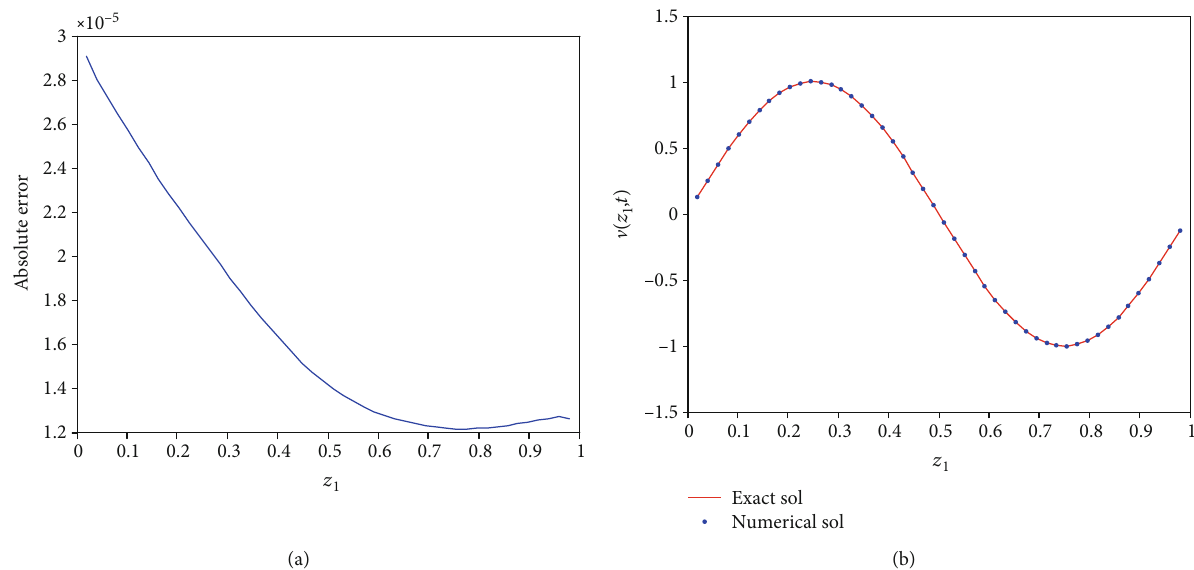
Figure 2: (a) E and (b) exact and approximate solution at α = 0 : 2 for the Problem 3. abs